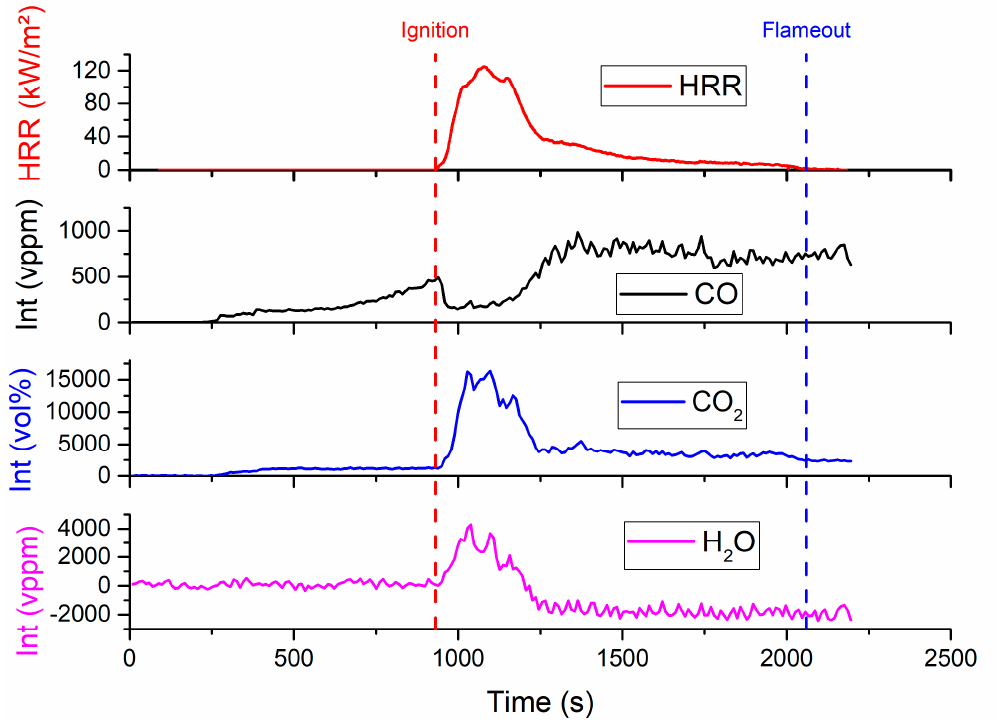
Figure 11. ( red ) HRR curve and intensity profiles of ( black ) CO, ( blue ) carbon dioxide (CO 2 ] vol% = [CO 2 ] ppm/1000) and ( magenta ) water when tested under the MLC at 50 kW/m².